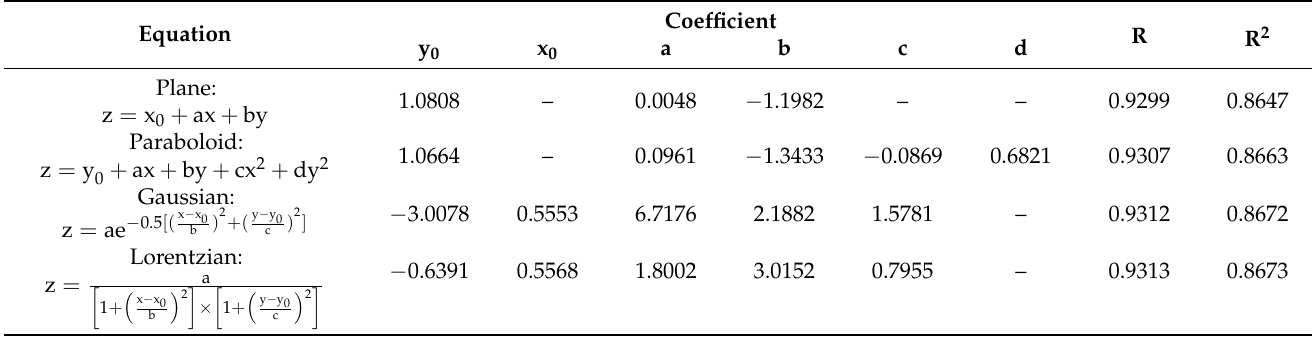
Figure 11. Design of an approximation surface for determining ε tp = P 2 /P 1 as function of the relative velocity of the evaporation chamber Ma (Mach number) and water injected relative amount g w. Table 2. Approximation functions and their coefficients for Figure 11.